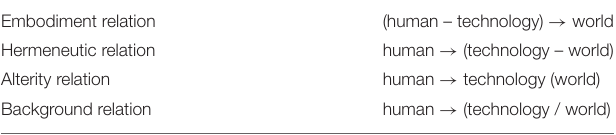
TABLE 1 | Human-Technology Relations Diagram (Ihde, 1990). Embodiment relation (human – technology) → world Hermeneutic relation human → (technology – world) Alterity relation human → technology (world) Background relation human → (technology / world) Arrows indicate